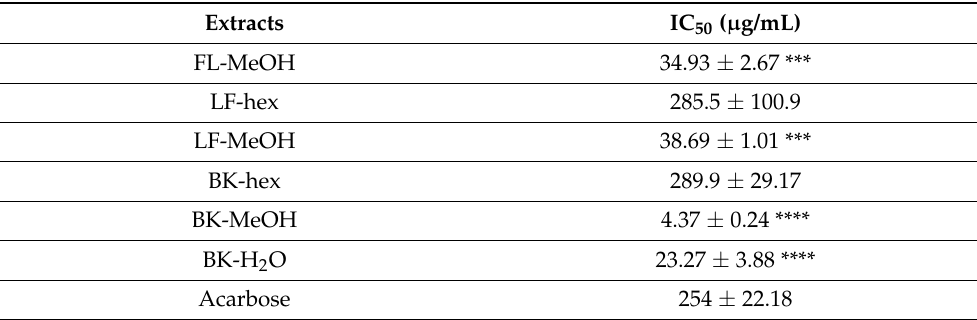
Table 3. IC 50 values of active extracts from flowers, leaves, and barks of A. saligna and acarbose against yeast α -glucosidase, *** p = 0.0004 of FL-MeOH extract vs. acarbose; **** p < 0.0001 were inhibition of the LF-MeOH, BK-MeOH, and BK-H 2 O extracts vs. acarbose ( n = 3, ANOVA, Dunnett). Extracts